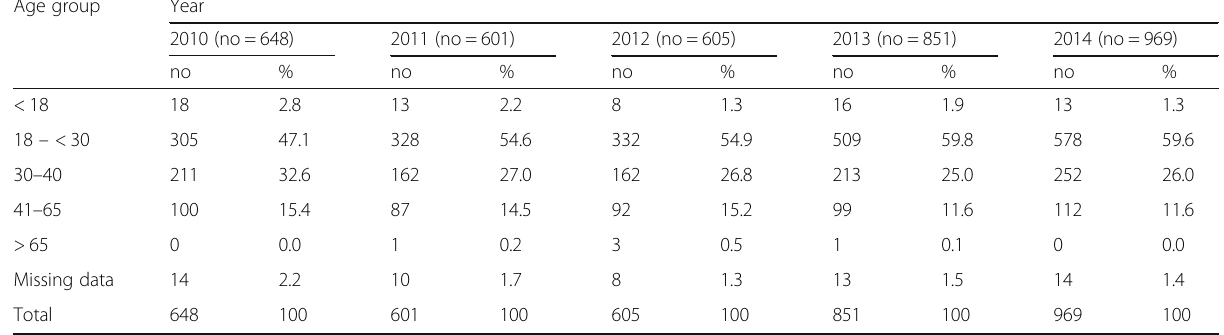
Table 1 Age distribution of captured persons with seized substances